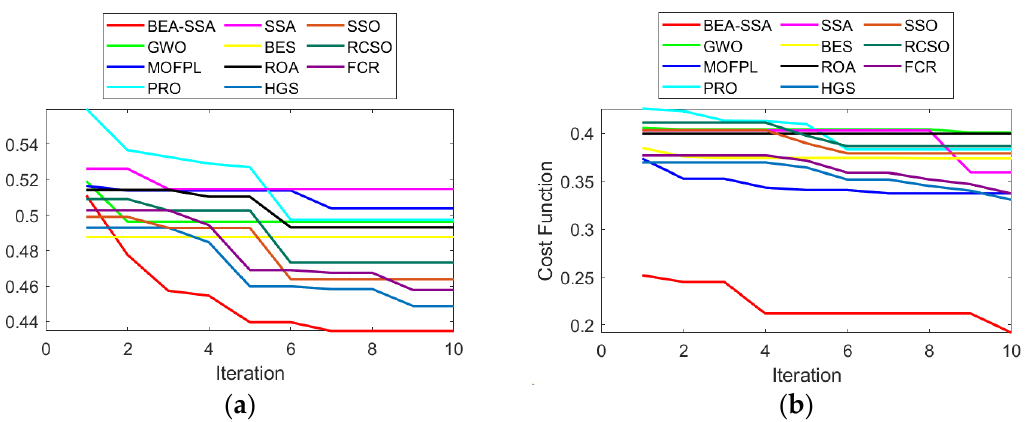
Figure 10. Convergence of BEA ‐ SSA approach compared with the other models [20–22,26] for ( a ) 100 and ( b ) 200